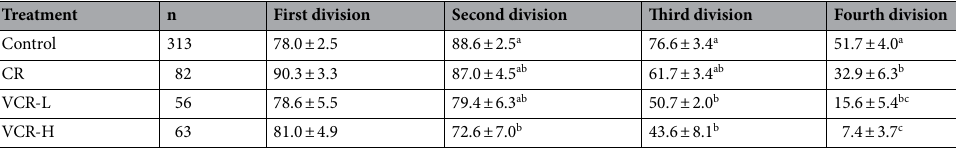
Table 5. Percentage of vitrified and fresh zygotes that reach each division. n = number of zygotes/embryos analyzed. Percentage of zygotes reaching different divisions. Different superscripts (a, b, and c) per column represent statistical differences ( p < 0.05). Results are stated as least square means ± standard errors. All oocytes were cultured in the Well-of the-well (WOW) system. Control: fresh cumulus enclosed oocytes. Corona Radiata (CR): fresh oocytes partially denuded to leave only the CR. VCR-H: CR oocytes vitrified with a protocol using high concentrations of cryoprotectants (15%) in equilibration solution; VCR-L : CR oocytes